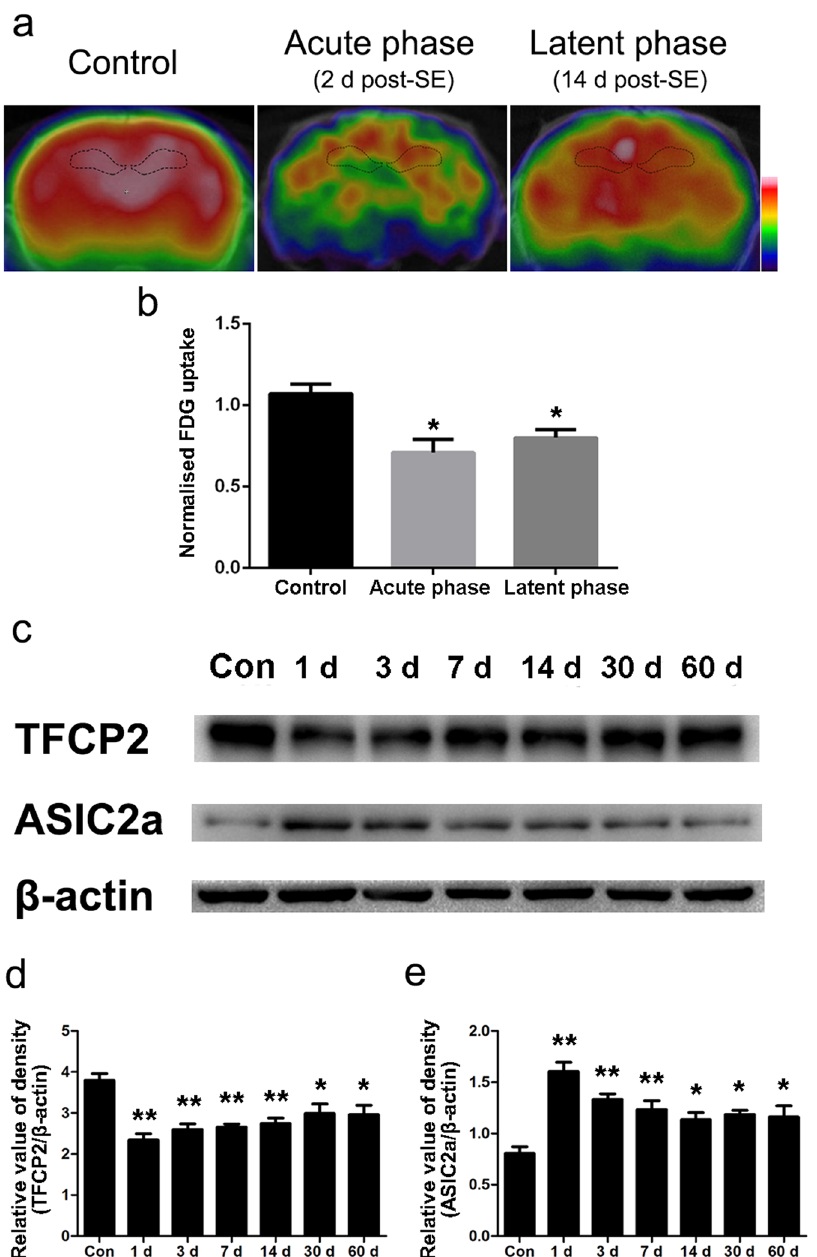
Figure 2. Altered hippocampal TFCP2 and ASIC2a expression with glucose hypometabolism in pilocarpine- treated rats. ( a ) Representative coronal view microscopic positron emission tomography images in the different phases of epileptogenesis. ( b ) Hippocampal glucose uptake in the different phases after pilocarpine injection. ( c ) Representative western blot assays of hippocampal TFCP2 and ASIC2a expression at different post-seizure time points. ( d ) Bar graph showing decreased hippocampal TFCP2 expression in pilocarpine-treated rats. ( e ) Bar graph showing increased hippocampal ASIC2a expression in pilocarpine-treated rats. The experiments were repeated at least 3 times with at least 3 rats in each group. Data are presented as means ± standard errors and were analysed using 1-way ANOVA and Dunnett’s multiple comparisons test. * P < 0.05 compared with controls, ** P < 0.01 compared with controls. Uncropped western blot images are shown in Supplementary Fig. 1. Abbreviations, ASIC2a: acid-sensing ion channel 2a; TFCP2: transcription factor CP2; SE: status epilepticus; Con: